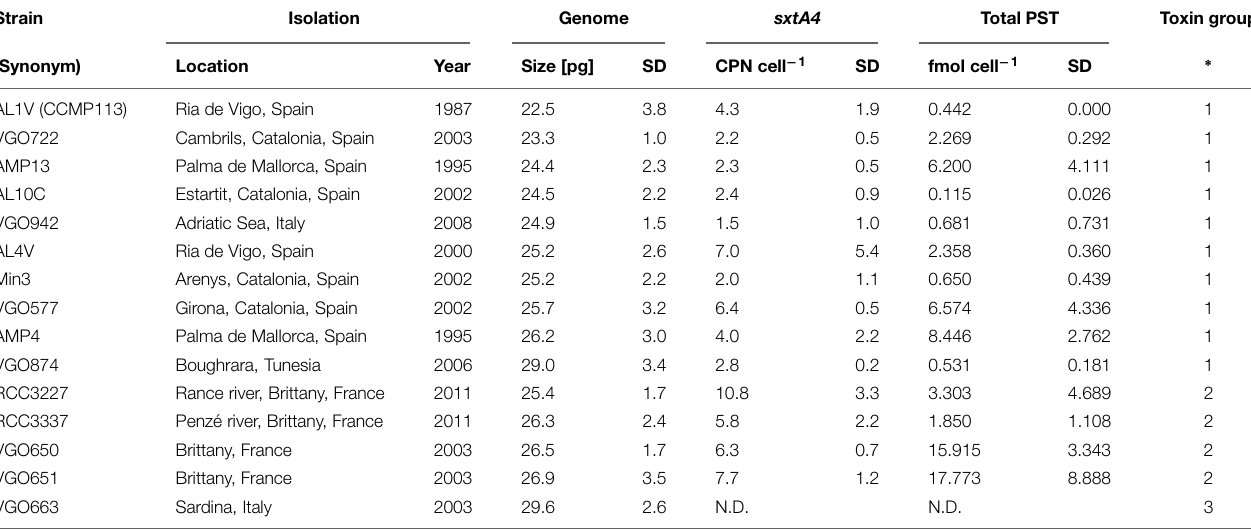
TABLE 1 | Overview over the Alexandrium minutum strains used in this study, their genome size, genomic sxtA4 CPNs, and average total PST content. Strain Isolation Genome Toxin group (Synonym)